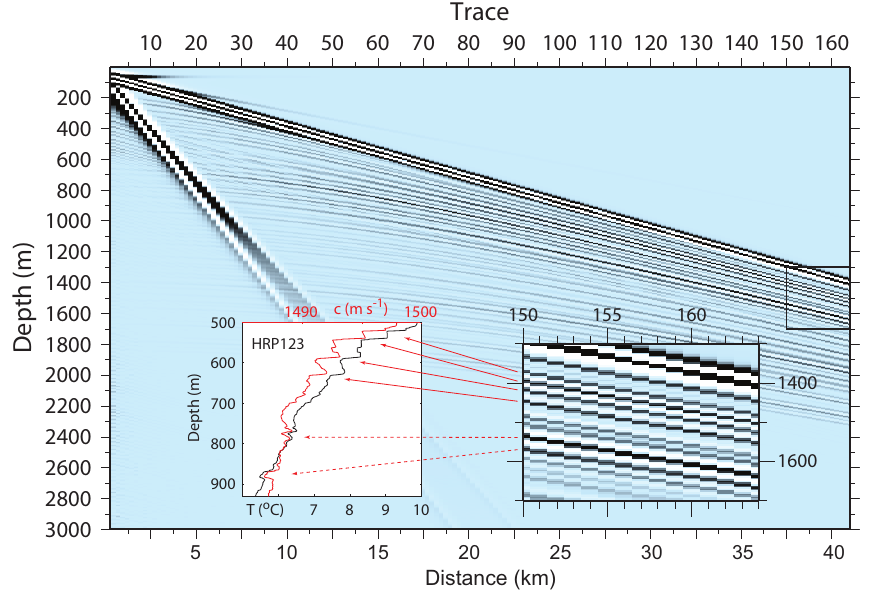
Fig. 9. Unstacked synthetic seismic shot gather using the CTD profile from HRP dive 123 east of Line D2 (Fig. 1). The direct arrival appears as large amplitude linear reflections starting at the sea surface. The airwave appears as the large linear event traveling at low velocity. Reflections from synthetic sound velocity and density structure calculated from the CTD are seen as hyperbolic horizons starting at about 200m at trace 1, at zero offset, which occurs directly below the source. Reflections from further offsets follow a hyperbolic moveout with respect to the zero offset trace, and are corrected to zero offset before stacking, using the appropriate sound speed to convert from time to depth. Note that only depths at zero offset correspond to depths on a stacked section. The synthetic staircase is imaged as the next strongest coherent packet of four reflections with the same moveout, visible at higher offsets. The insets show (left) a portion of the sound speed and temperature profiles from HRP dive 123 and (right) a blow-up of the synthetic seismic shot gather marked by the rectangle. Red arrows associate the staircase reflections with the measured staircase. Also shown are relatively strong deep reflections associated with the two intrusive features (dashed